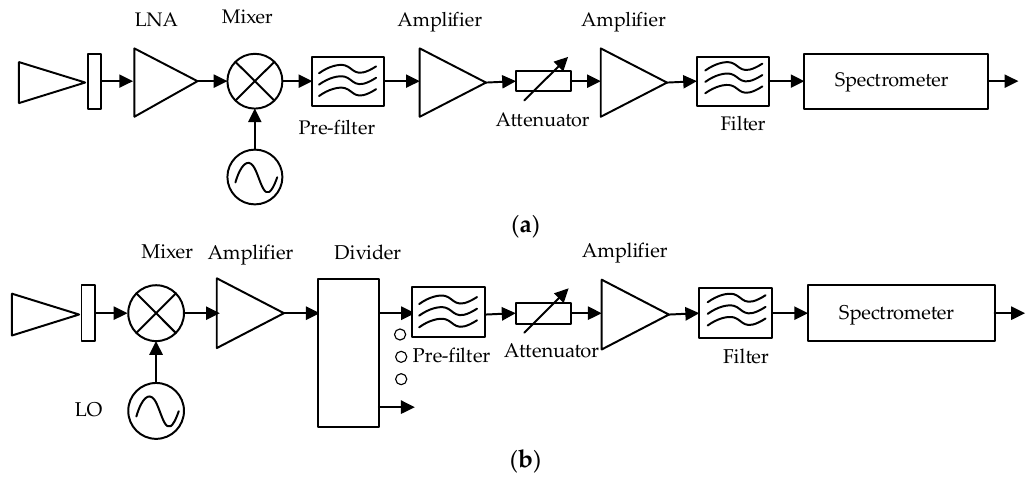
Figure 2. The block diagram of the TALIS instrument: ( a ) 118 GHz; ( b ) other bands.